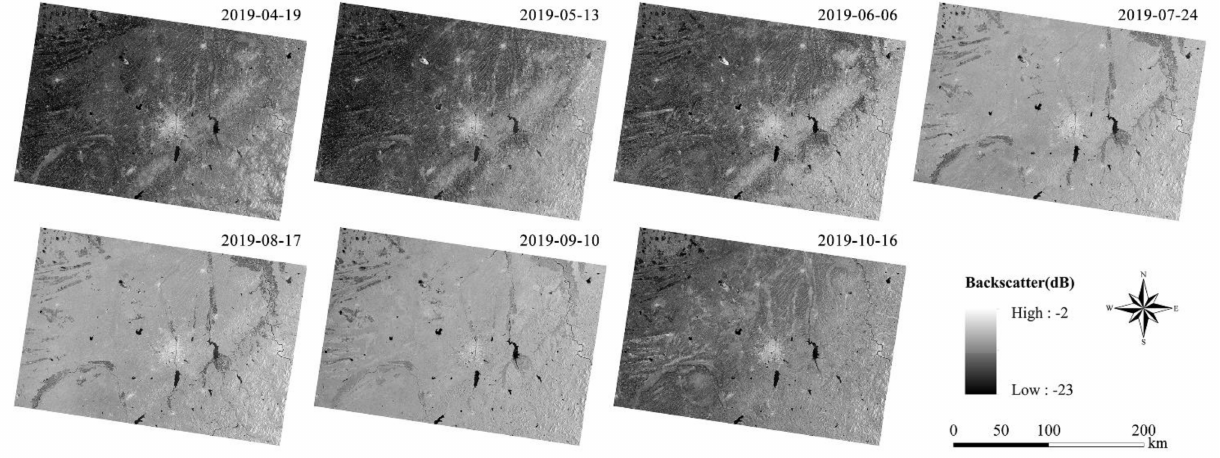
Figure 2. The multi-temporal Sentinel-1 VV polarization backscattering coefficient after being pre-processed in the study area. The incidence angle of each image is 31–46 ◦ from right to